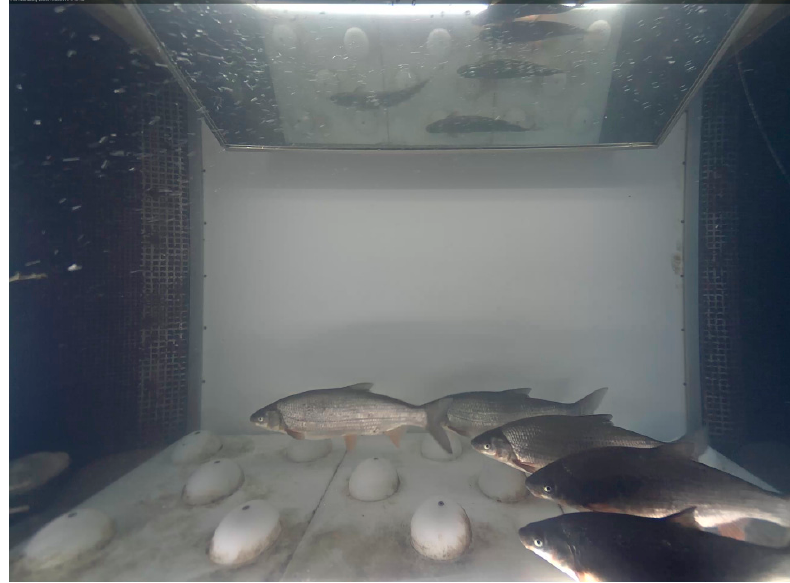
Figure 4. FishCam picture from detected Chondrostoma nasus (sneep): plain view and vertical